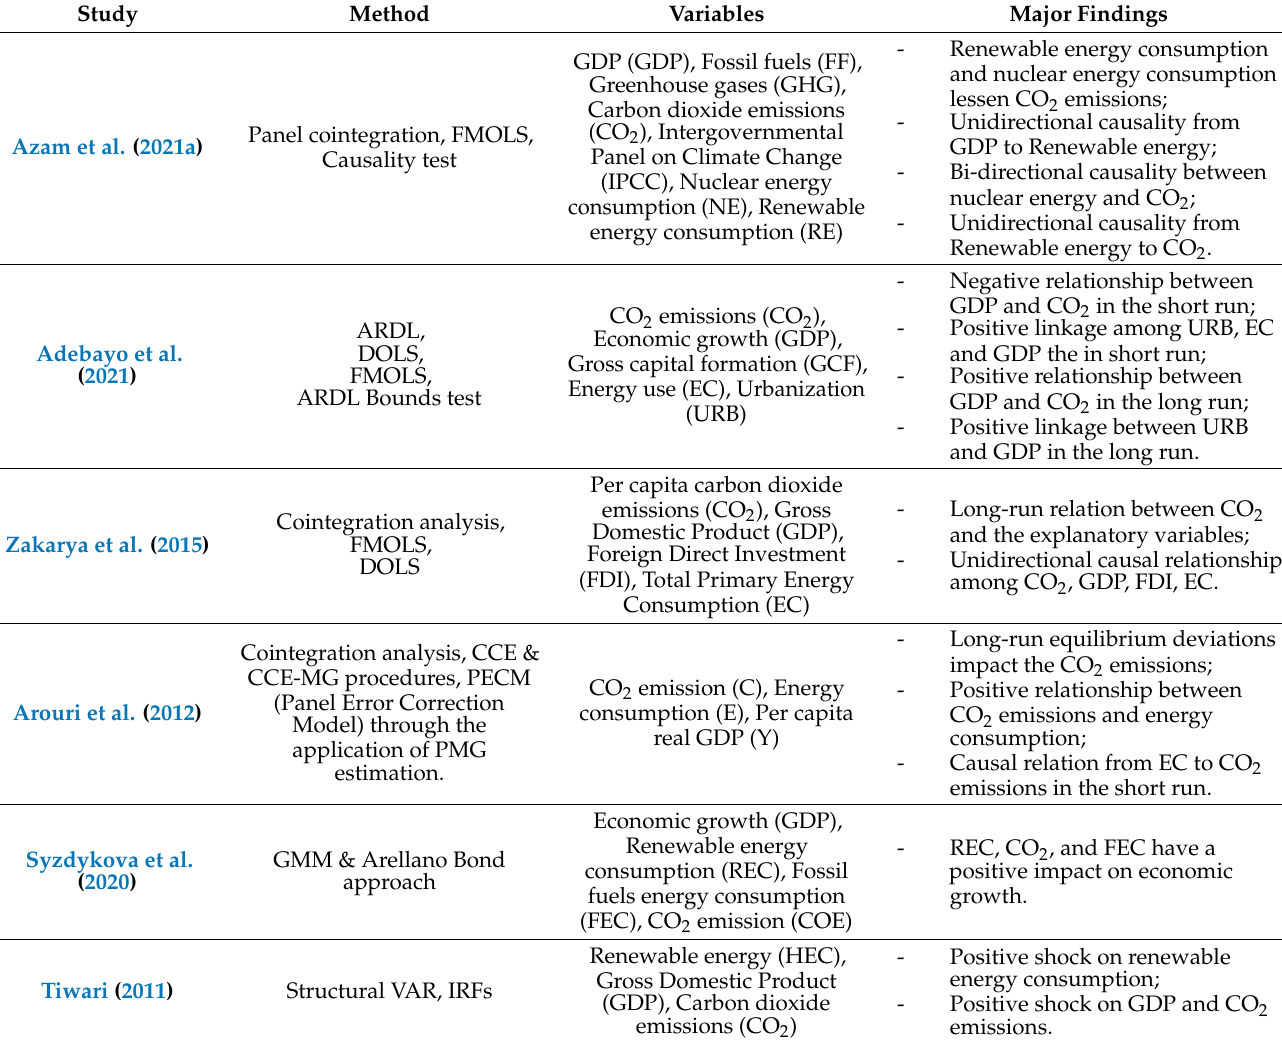
Table 1. List of Empirical Studies Using ARDL and GMM models for the study of CO 2